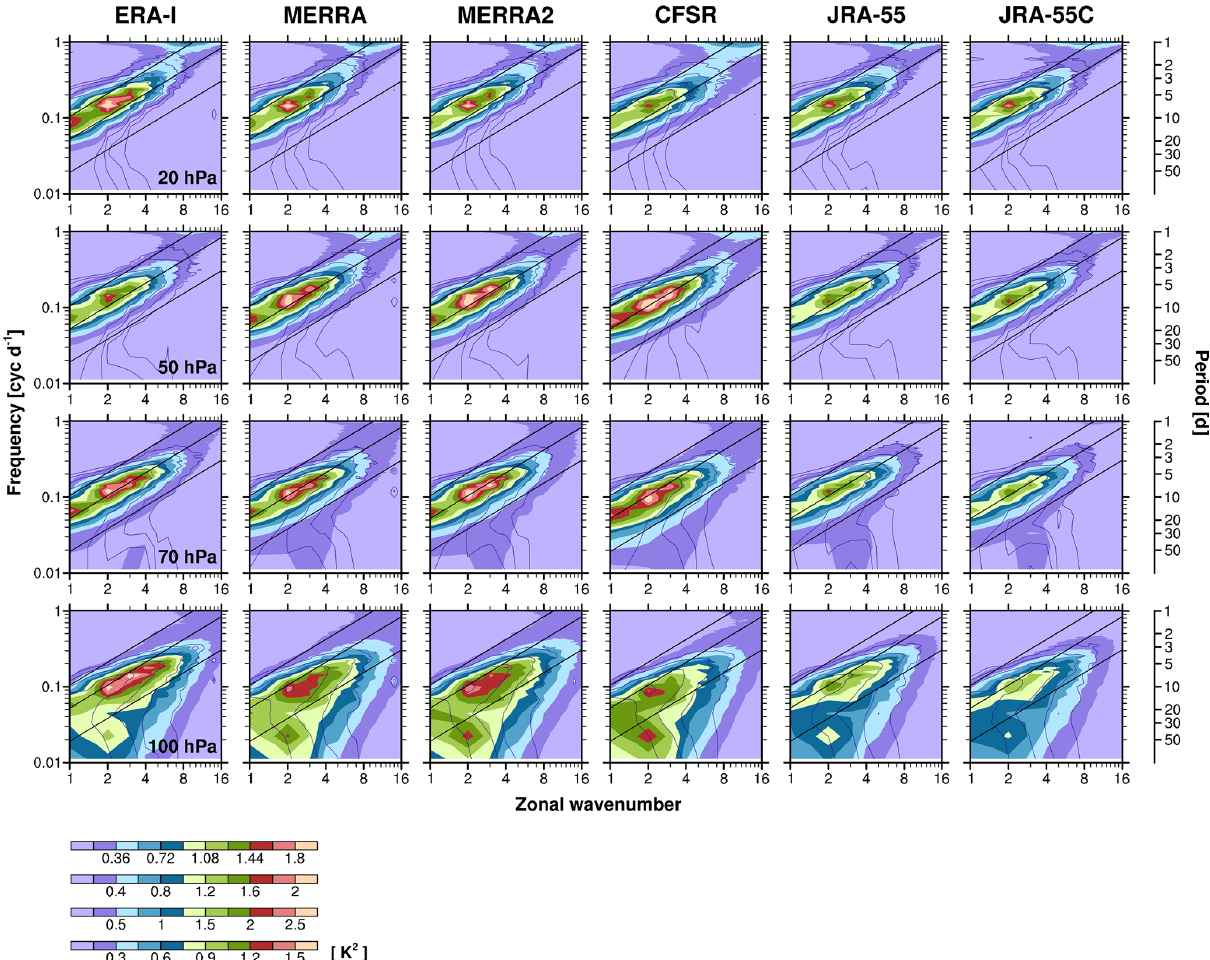
Figure 1. Zonal wavenumber–frequency power spectra of the symmetric component of temperature at 100, 70, 50, and 20hPa (from bottom to top) from the standard-level datasets of six reanalyses (ERA-I, MERRA, MERRA-2, CFSR, JRA-55, and JRA-55C: from left to right), averaged over 15 ◦ N–15 ◦ S in 1981–2010. The power spectra are presented in the variance-preserving form with log-scale axes. The Kelvin wave dispersion curves are indicated by black diagonal lines for the equivalent depths ( h ) of 8, 60, and 240m. The ratio of the spectral power to that of the background spectrum is indicated by thin purple contours for the values of 1.5, 2, 3, and